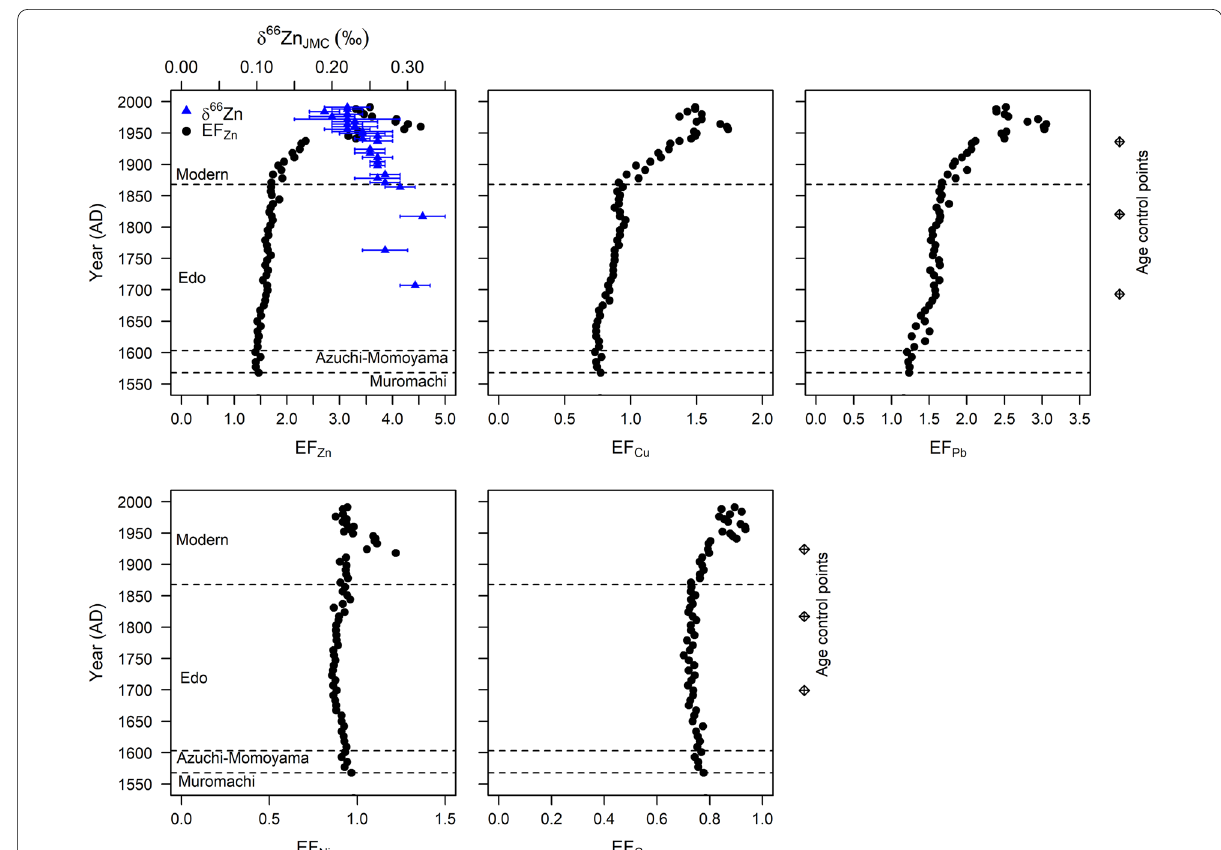
Fig. 6 Time profiles of δ 66 Zn and of the enrichment factor (EF) of Zn, Cu, Pb, Ni, and Co in the piston core during the last 450